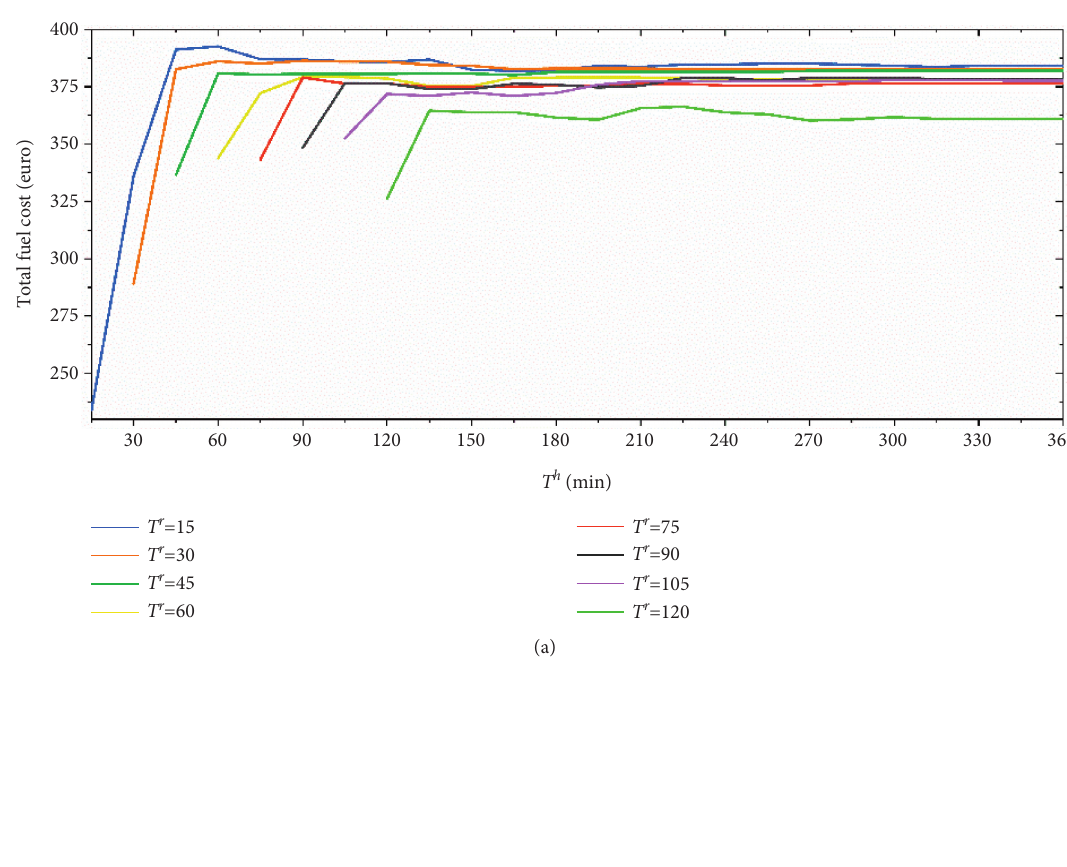
Figure 7: Results of parking